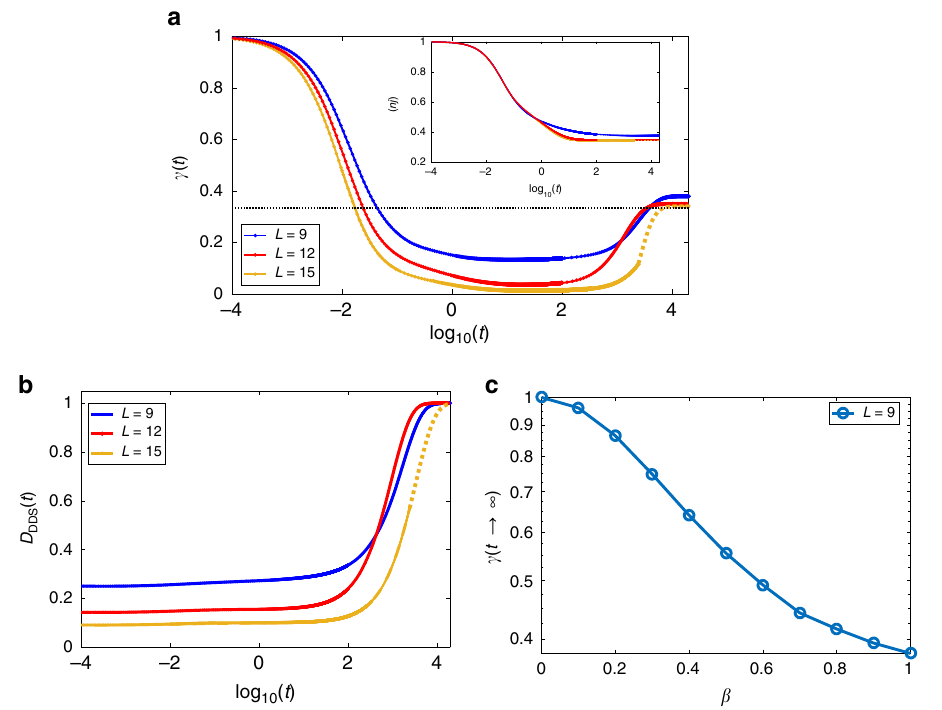
Fig. 4 Time evolution and decay into the DDS. a Evolution of the purity γ ( t ), for different sizes. Starting from a pure CDW state, the system becomes highly mixed before starting leaking into the DDS. The dotted line shows the minimum purity possible in the DDS, corresponding to a fully mixed state. Inset: Evolution of a local observable (density). We observe that the local density relaxes to it value in the DDS in a shorter timescale compared with the time required for the system to enter the DDS. This happens independently of the system size. b Approach of the DDS, spanned by the Laughlin-like states on the narrow torus, for different system lengths L . c Purity in the DDS as a function of β . The purity of the DDS depends strongly on β , indicating that the purity can be maintained if the fi nal state is close to the initial one. The dotted lines for the L = 15 case for the purity and density evolution are obtained from an approximation for the Lindbladian on a smaller subspace. In the approximation we neglect the terms of the evolved state ρ ( t ) which are smaller than a threshold ϵ = 10 − 5 and construct the effective Lindbladian for the remaining subspace, which has a smaller dimension. The dotted lines for L = 15 for the D DDS are obtained from the knowledge of the ADR, and simply performing a continuation of the